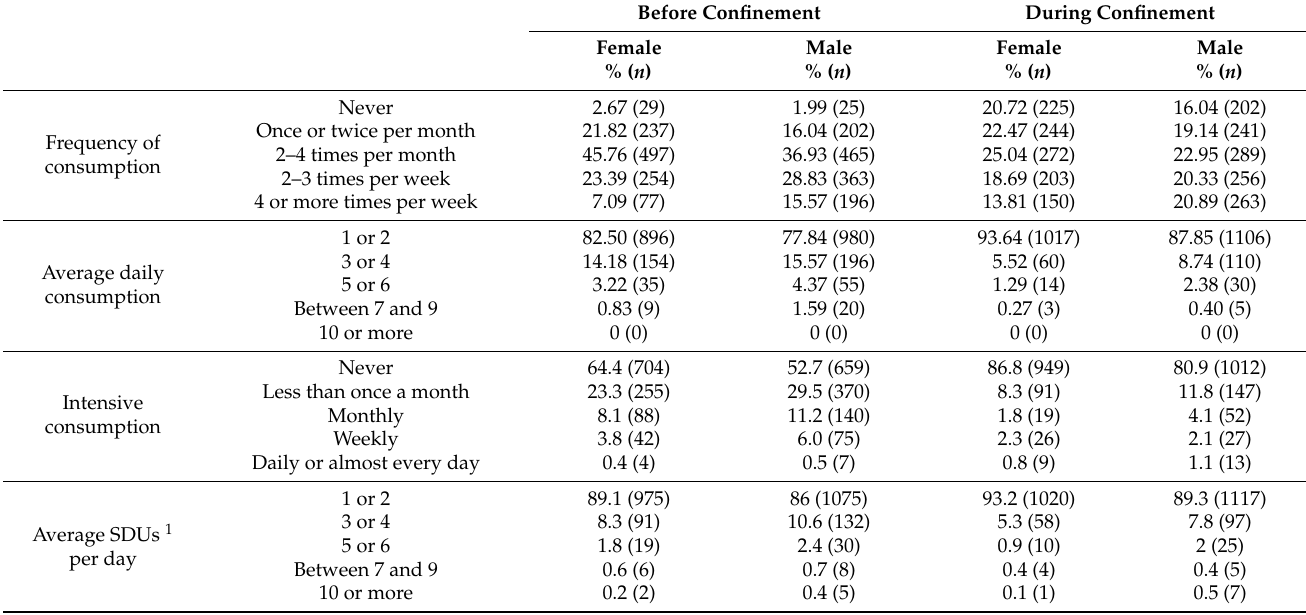
Table 1. Prevalence of the frequency of consumption rate and average daily intake of alcohol before and during confinement, as a function of gender.